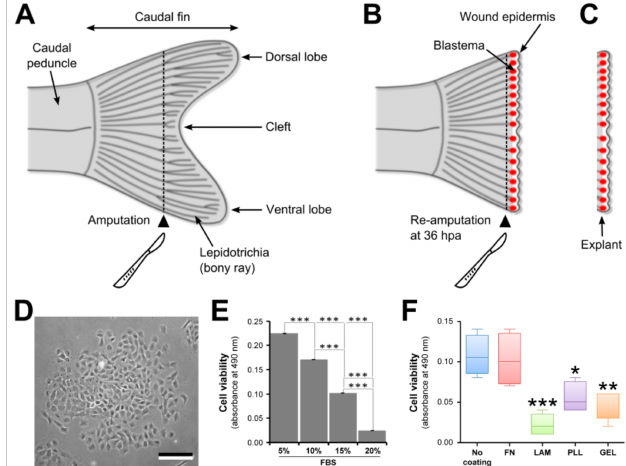
Figure 1. Schematic diagram for caudal fin amputation, blastema collection, and blastema cell culture. ( A ) Amputation of the caudal fin; ( B , C ) re-amputation procedures towards blastema collection. Dotted lines indicate amputation and re-amputation planes. Blastema is indicated in red; ( D ) phase-contrast micrographs of zebrafish blastema cell cultures at 72 h post-seeding; ( E ) viability of blastema cells cultured in medium supplemented with different concentrations of FBS; ( F ) viability of blastema cells cultured on surfaces coated with different molecules. In ( E,F ), cell viability was measured 72 h post-seeding and asterisks indicate values significantly different through one-way ANOVA followed by Tukey’s ( E ) or Dunnett’s ( F ) multiple comparison test (*** p < 0.001, ** p < 0.01, and * p < 0.05; n = 6). FN, fibronectin; LAM, laminin; PLL, poly-L-lysine; GEL, gelatin. Scale bar in ( D ) is 100 µ